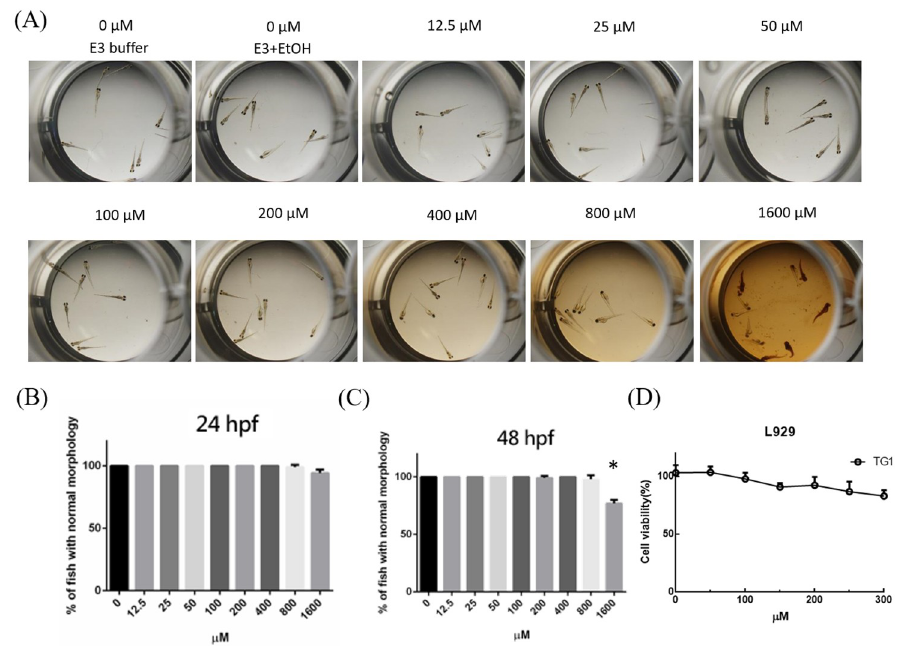
Fig 2. The effects of TG1 on the development of zebrafish embryos. (A) Representative images of zebrafish embryos exposed to TG1 at 48h. Survival rate after exposure to 12.5uM to 1600uM TG1 at (B) 24 and (C) 48 hpf. (D) Inhibition of TG1 on cell viability of L929 cells. (E3: E3 medium, for zebrafish embryos; EtOH: ethanol; hpf: hours post fertilisation) Data were shown by mean ± SD (standard deviation), n = 3. � p < 0.01, which indicated the groups had significant difference as comparing to control